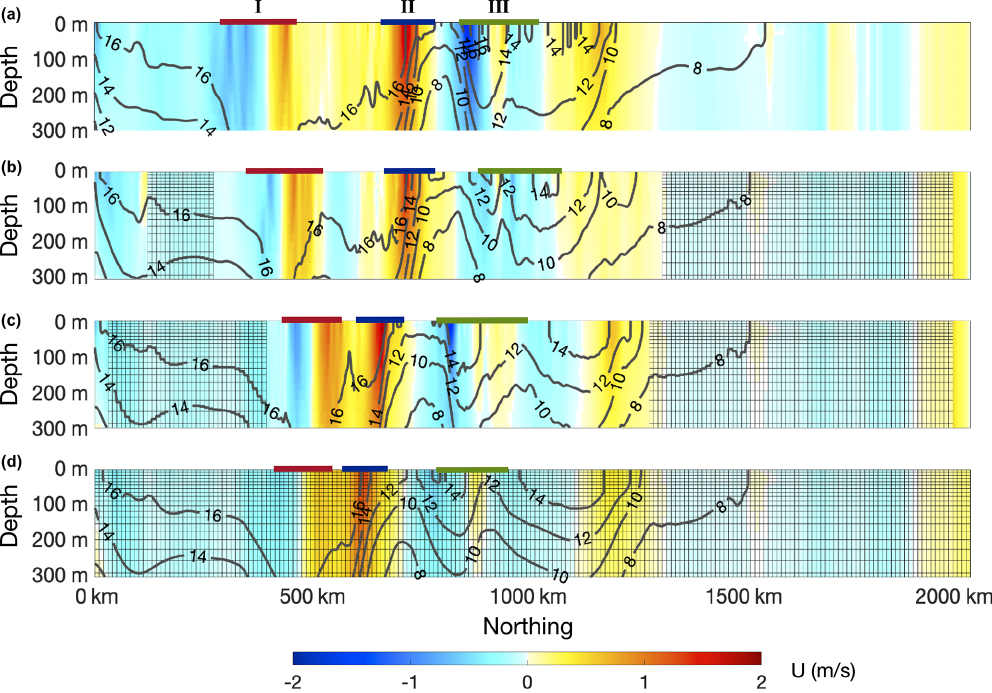
Figure 14. Typical meridional–vertical transects (top 300m) in Fig. 12. Temperature (contour lines) and zonal velocity (filled contour) are shown in each panel. The four experiments, S, M-S-I, M-S-I, and M, are shown in order from (a) to (d) . Grids in the lower three panels show the region with 0.1 ◦ resolution (i.e., not refined). In each panel, the three features are marked: I for the mesoscale eddy in the subtropical gyre, II for the core of the western-boundary current, and III for the submesoscale-rich region to the north of II.